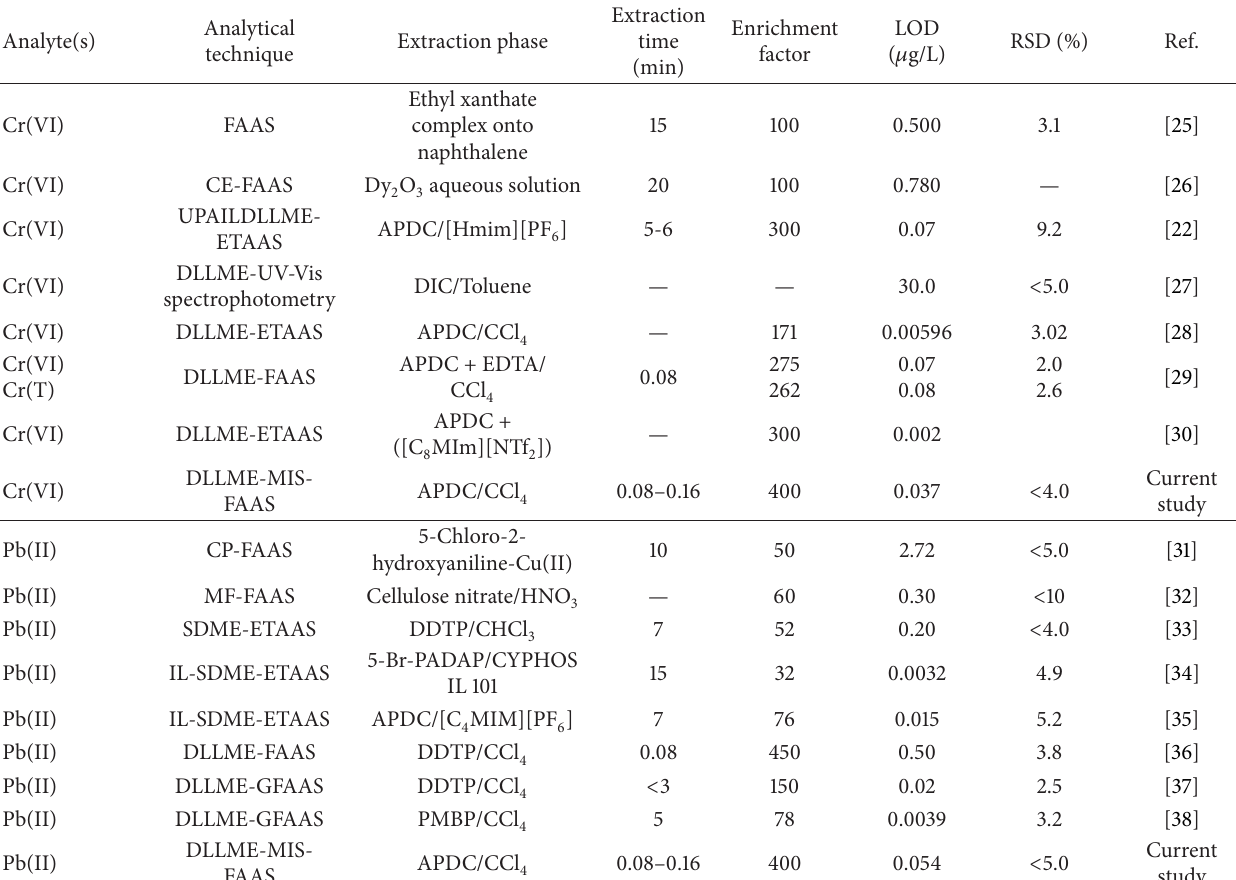
Table 3: Comparative data of analytical characteristics of the literature reported methods and proposed method.